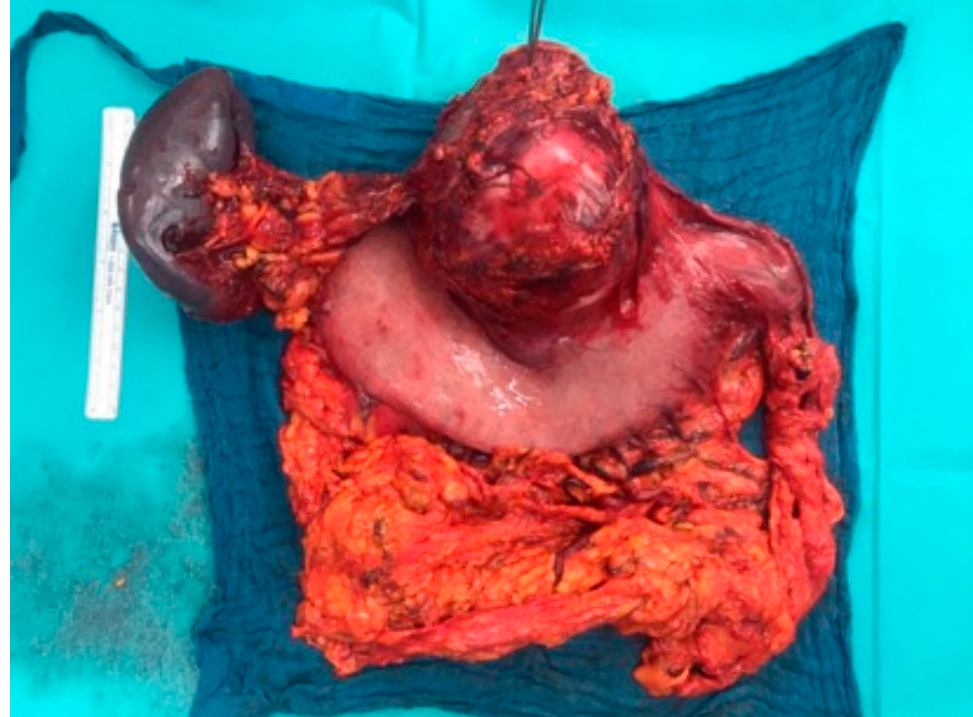
Figure 1. Macroscopic overview of the tumor from dorsal side. The tweezer marks the pancreatic resection margin with the passing lienal artery.